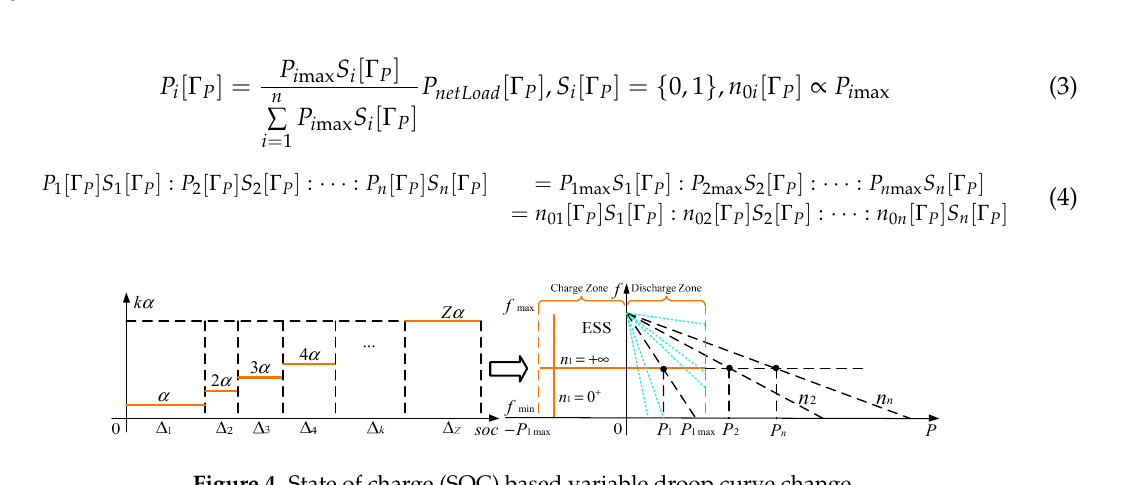
Figure 4. State of charge (SOC) based variable droop curve change.